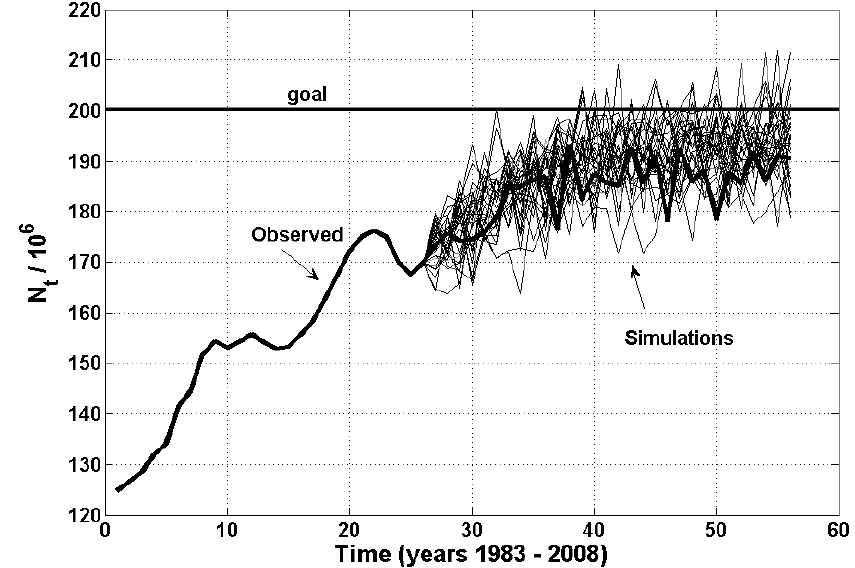
Fig. 3 – Simulation of the trajectories of N t for 30 years